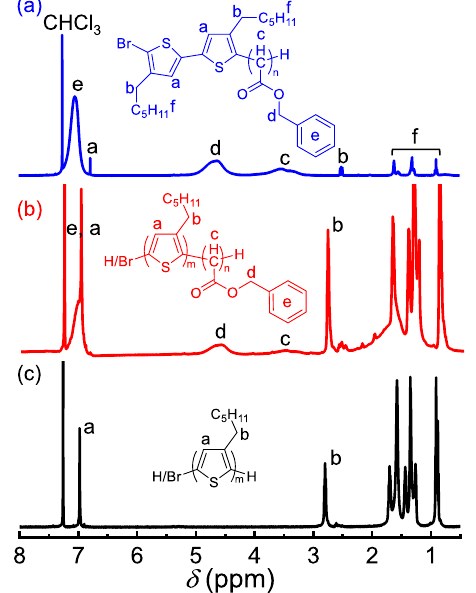
Fig. 4 1 H NMR spectra. 1 H NMR (400 MHz, CDCl 3 ) spectra of poly- 1a 20 ( a ), poly( 2 20 - b - 1a 40 ) ( b ), and poly- 2 20 ( c ) obtained at room